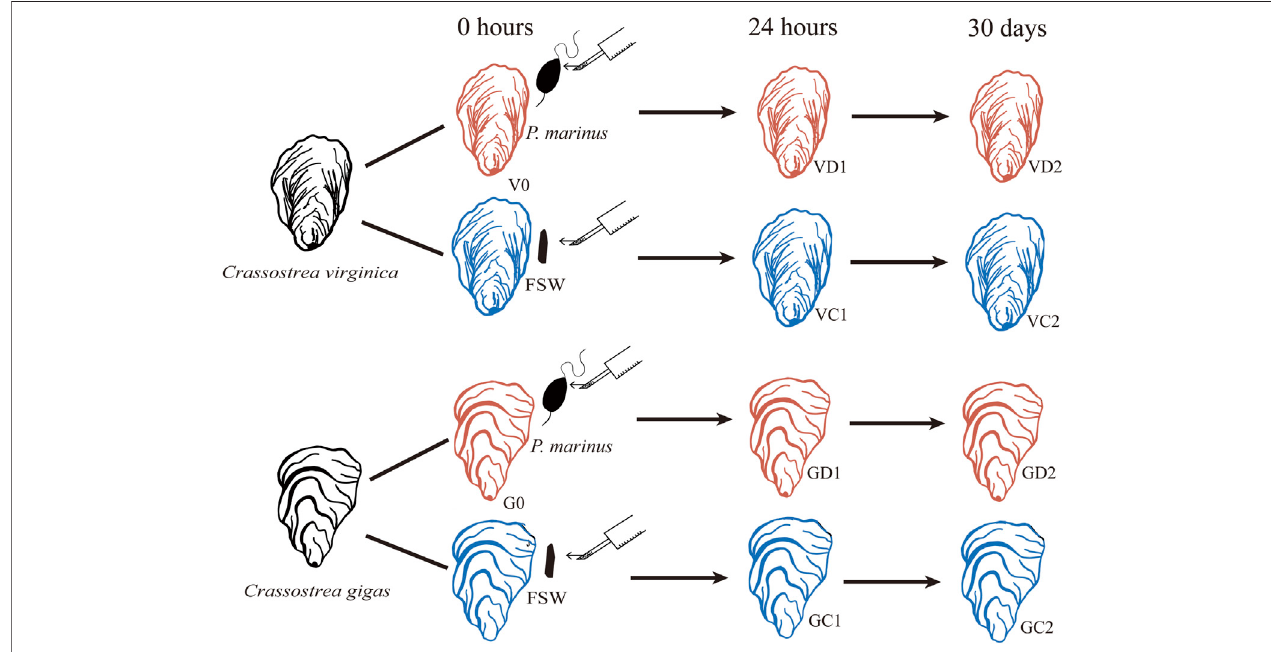
FIGURE 1 | Schematic diagram of experimental design. FSW, fi ltered